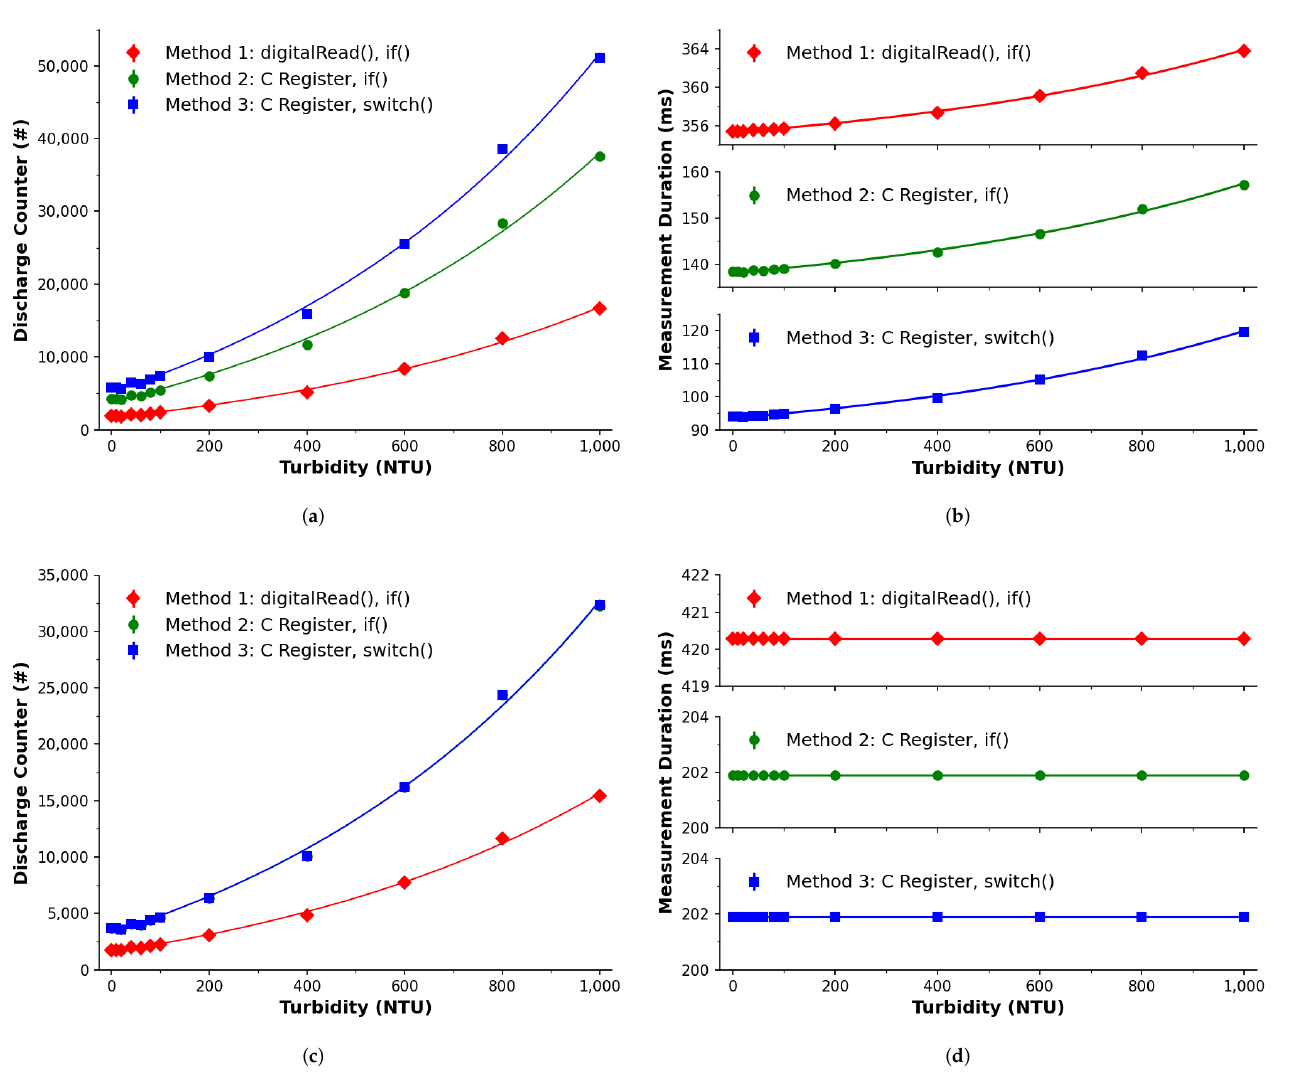
Figure 4. Turbidity calibration of the PEDD system adopting the literature derived (top: a , b ) and proposed (bottom: c , d ) approaches and compared using three software implementation methods. The average of multiple measurements are represented by the markers the standard deviation is represented by the error bars, and the lines show a fitted power model ( y = Ax τ + y 0 ). Method 1 ( (cid:7) ), Method 2 ( ) and Method 3 ( (cid:4) ) are implementations of the parameters listed previously in (cid:32) Table 2. ( a ) Software counter: uncorrected T s . ( b ) Measurement duration: uncorrected T s . ( c ) Software counter: corrected T s . ( d ) Measurement duration: corrected T s